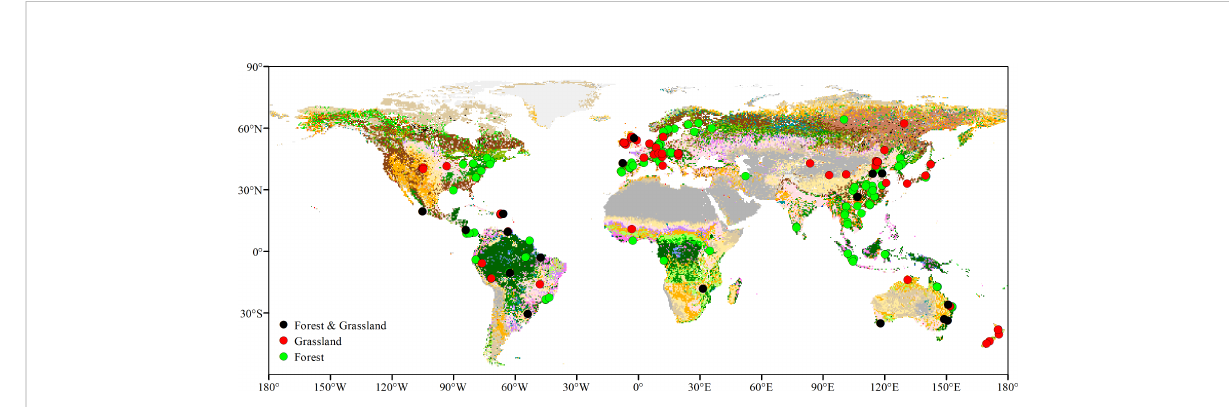
FIGURE 1 Global distribution of the experimental sites with measurements of annual N 2 O emission fl uxes. The map was generated using ESRI ArcGIS 10.0 (URL: http://www.esri.com), and the coordinate system is WGS84. The base image was acquired and modi fi ed from GLC2000 database (30)